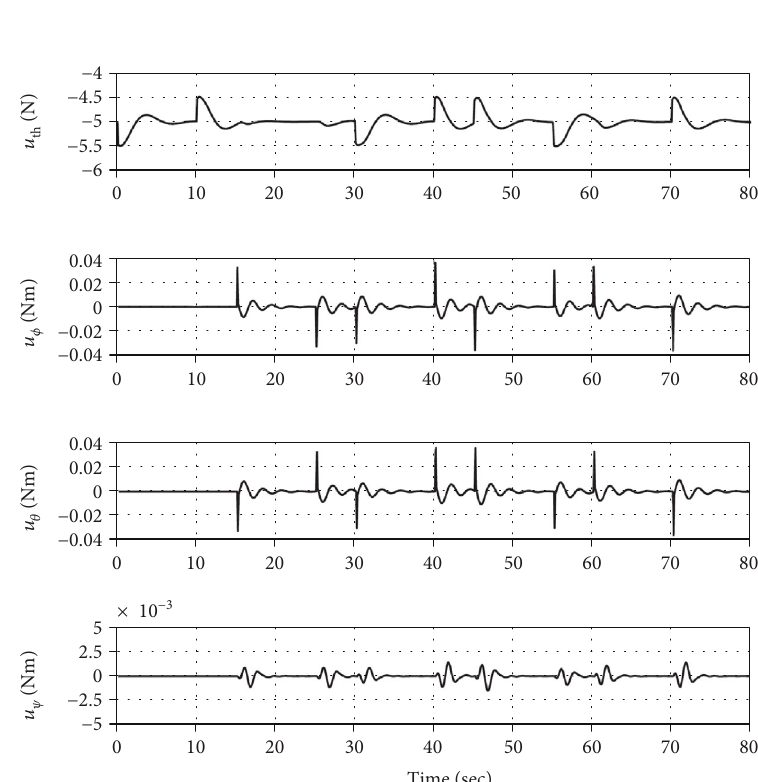
Figure 12: Time history of control